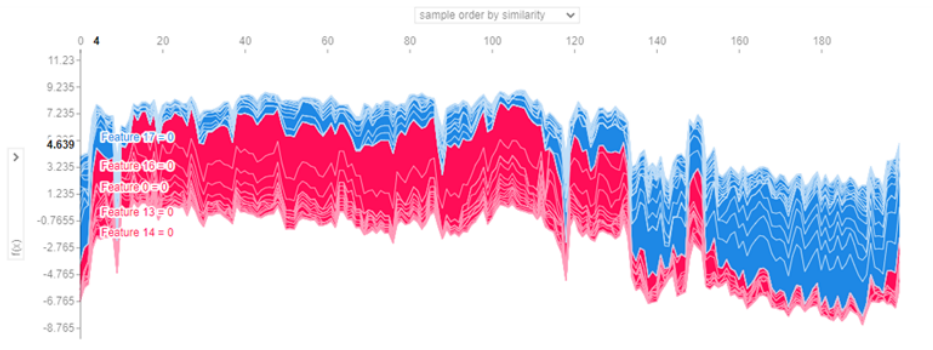
Figure 14. Collective force plot for the developed